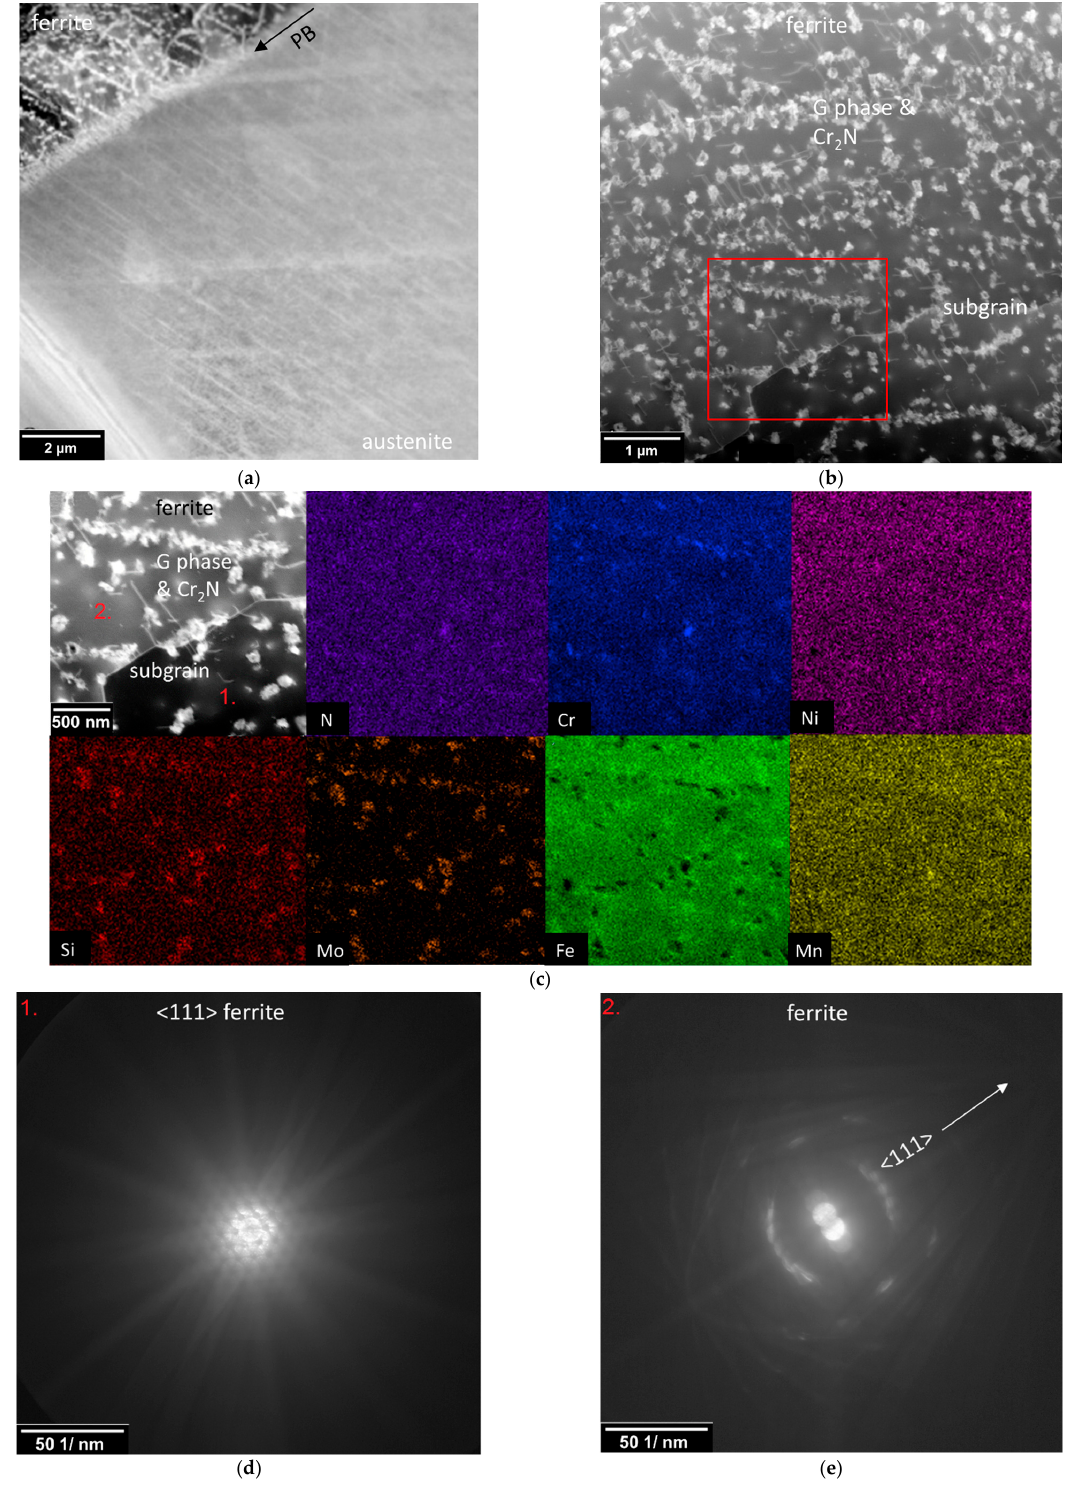
Figure A5. Detailed STEM images of the dislocation arrangement in austenite ( a ) and ferrite ( b ) and STEM-ADF image of precipitates in ferrite and ( c ) the corresponding EDX mapping of the highlighted area in ( b ) of the elements N, Cr, Ni, Si, Mo, Fe and Mn after thermomechanical fatigue in IP condition. ( d , e ): Diffraction pattern on the CETA camera in STEM mode of the marked locations in ( c ) (1. corresponds to ( d ), 2. corresponds to ( e )). Serval degrees of tilt difference between ( d ) in ferrite <111> ZA and ( e